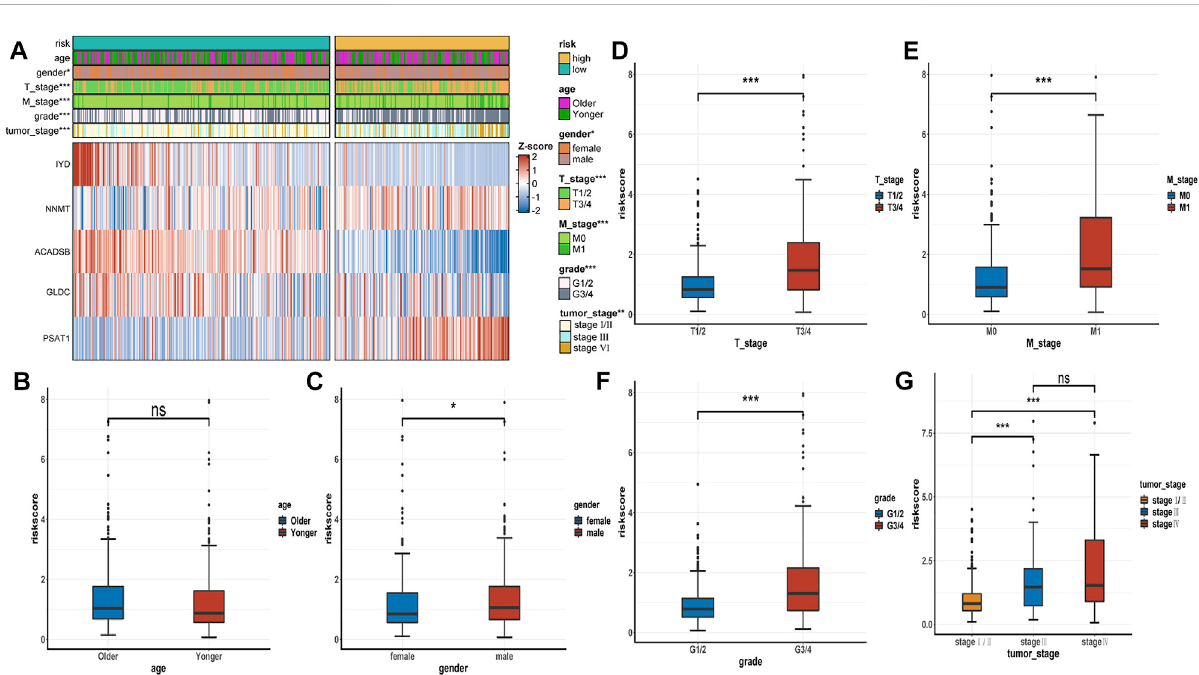
FIGURE 6 The correlation between the AAM-related gene signature and clinical traits. (A) Heatmap plot displayed the correlation between the risk group and other clinicopathological traits; (B – G) Boxplot showed the correlation between the risk scores and clinicopathological traits; T: AJCC